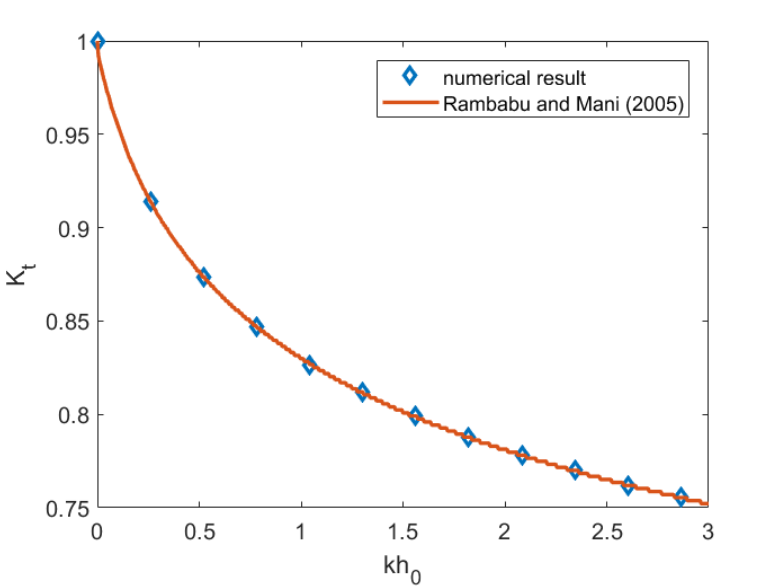
Figure 7. Comparison between numerical K t obtained by [31] and by our model (SWE